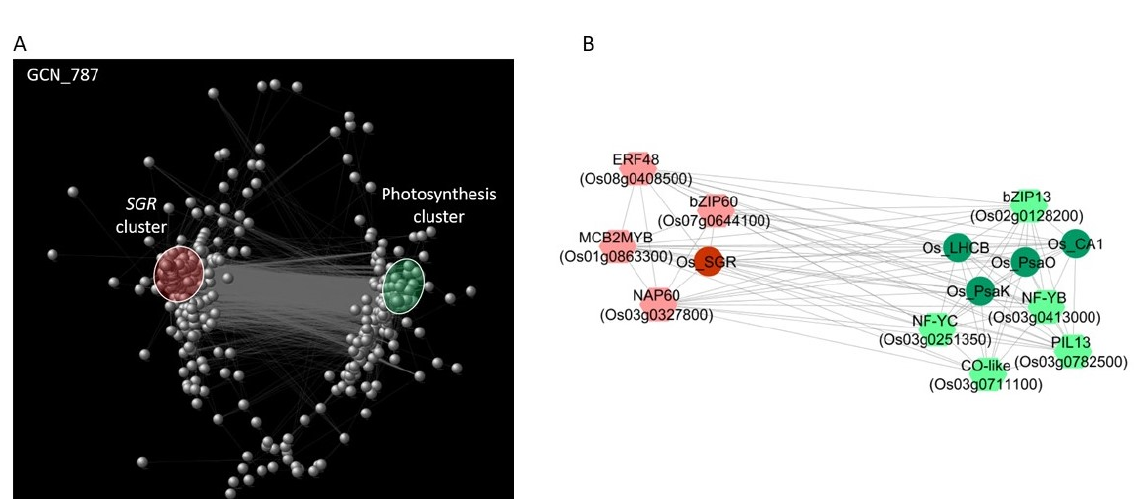
Figure 5. ( A ) Gene co-expression network (GCN) created with Cytoscape related to an independent osmotic stress experiment [28]. The nodes indicate the 787 genes belonging to the network, that is, CDT genes and DEG–TFs. Grey lines represent significant ( p -value ≤ 0.05) gene expression correlations higher than |0.9|. The two negatively correlated groups of the GCN, which correspond to the two negatively correlated clusters shown in Figure 4C and are related to photosynthesis genes and SGR, are highlighted in green and red, respectively. ( B ) Graphical representation of the principal GCN hub genes related to photosynthesis and SGR pathways that are discussed in the text. Grey lines represent significant ( p -value ≤ 0.05) gene expression correlations higher than |0.9|.